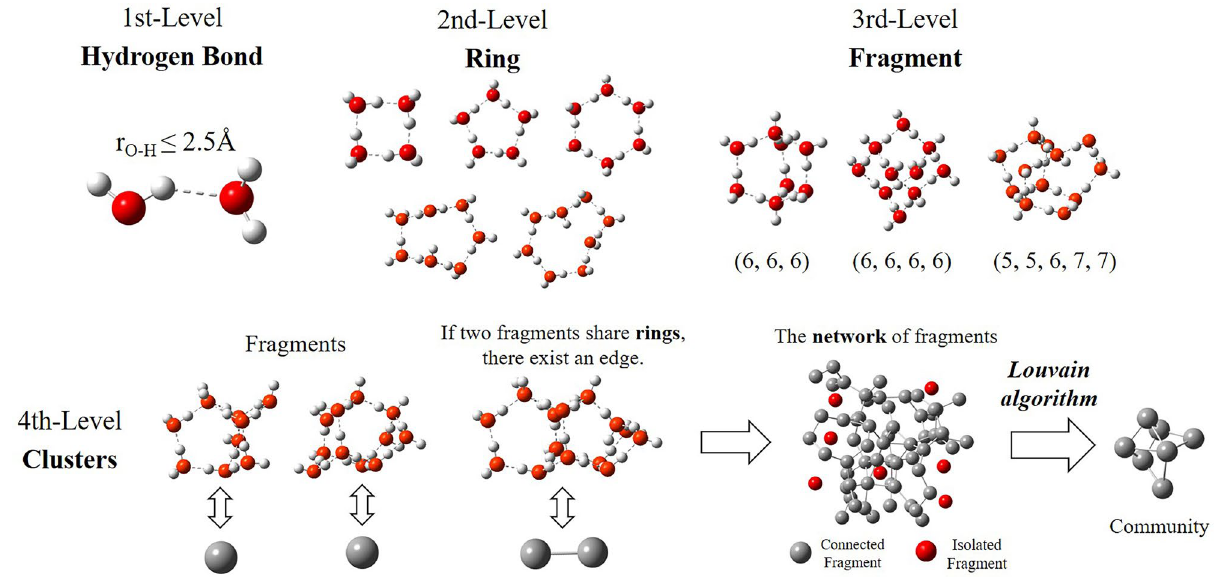
Figure 8. Schematics of the extended hierarchical clustering method. Hydrogen bonds, rings and fragments are considered 1st-, 2nd-, and 3rd-level structures, which are ball-and-stick models from a chemical perspective, and the red and white balls denote oxygen and hydrogen atoms, respectively. The full and dotted sticks denote O–H and hydrogen bonds, respectively. The clusters are illustrated from a topological perspective. The balls represent the graph community as water clusters. Note that the structures in the figure are only a selection among the considered structures by the clustering algorithm. The structures are drawn by GaussView 5.0.8 69